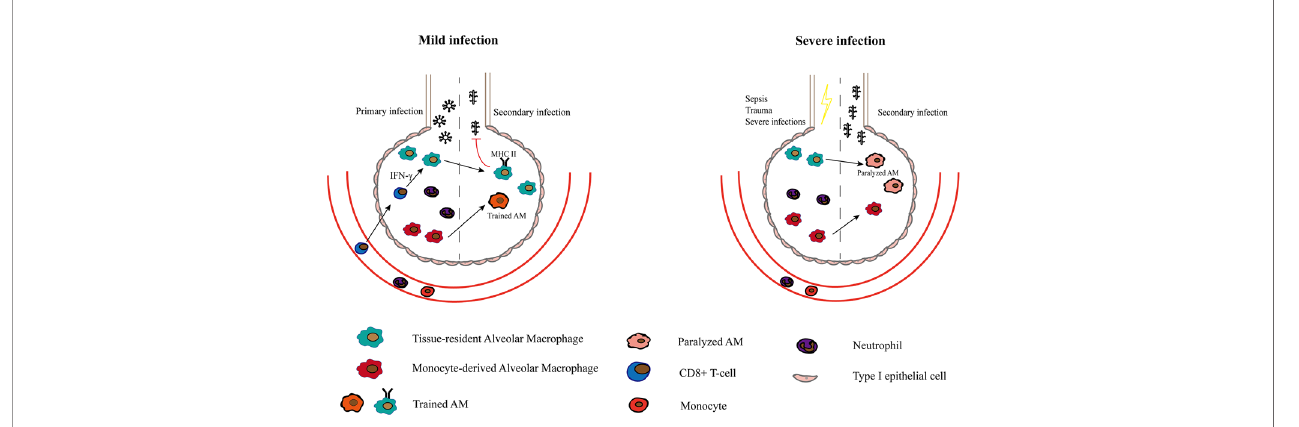
FIGURE 2 | The role of Macrophages in secondary infection and trained immunity. After a mild infection caused by a speci fi c pathogen such as adenoviruse, TR- AMs upregulate MHC II expression in response to CD8+ T lymphocytes and are rapidly activated in secondary infections (81). Mo-AMs that persists in the alveolar cavity after primary infection are also more likely to be activated and form part of trained AMs. After recovery from severe infections, TR-AMs are paralyzed with reduced phagocytosis and are more susceptible to secondary